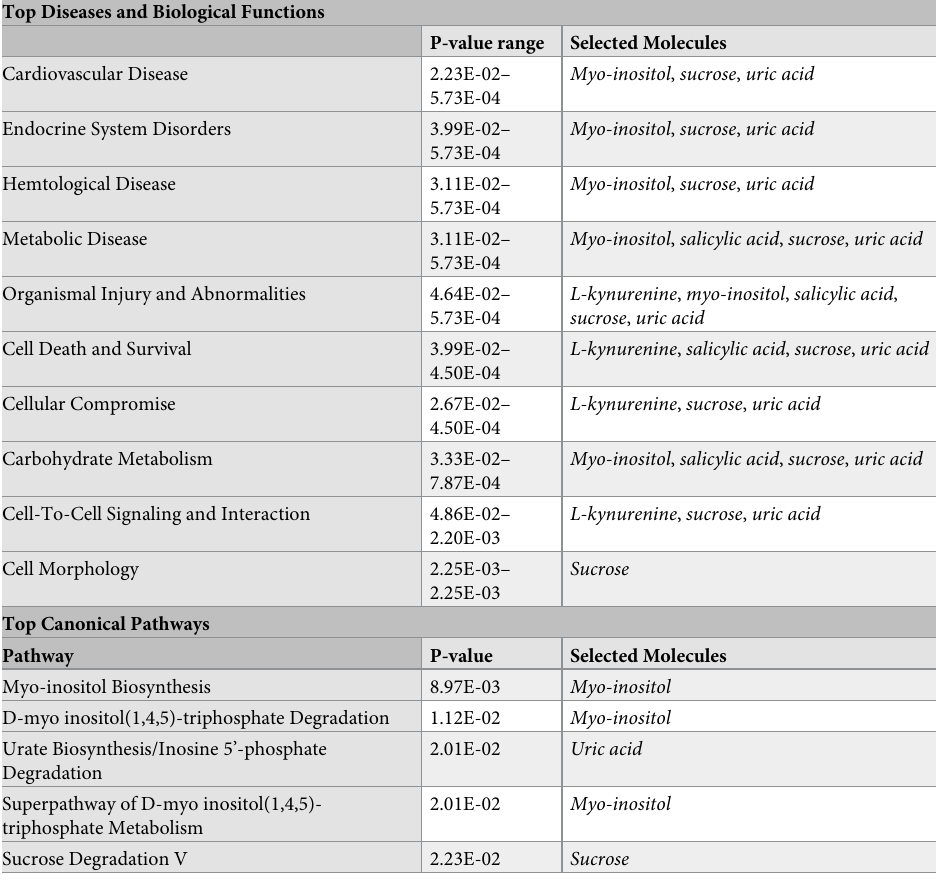
Table 11. Enrichment analysis of metabolites associated with COVID-19 severity (all patients).